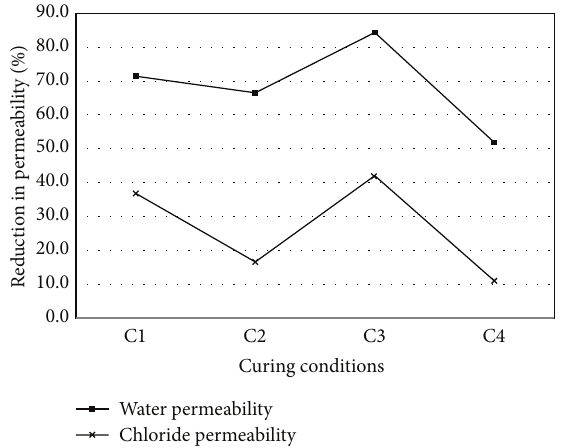
Figure 11: Reduction of water and chloride permeability in SP samples with respect to control samples under C4 curing